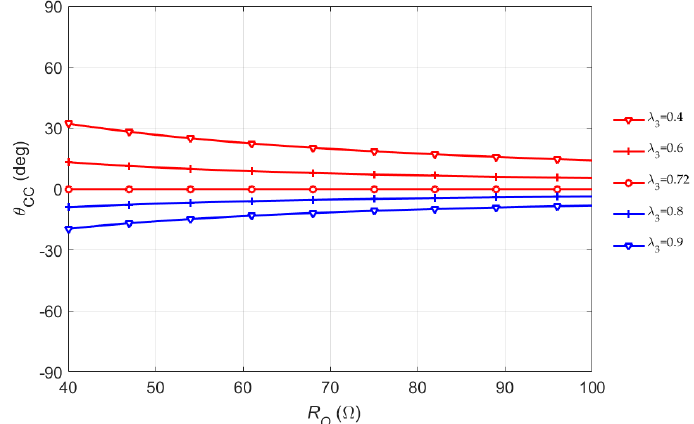
Figure 8. Phase angle of input impedance in CC mode.